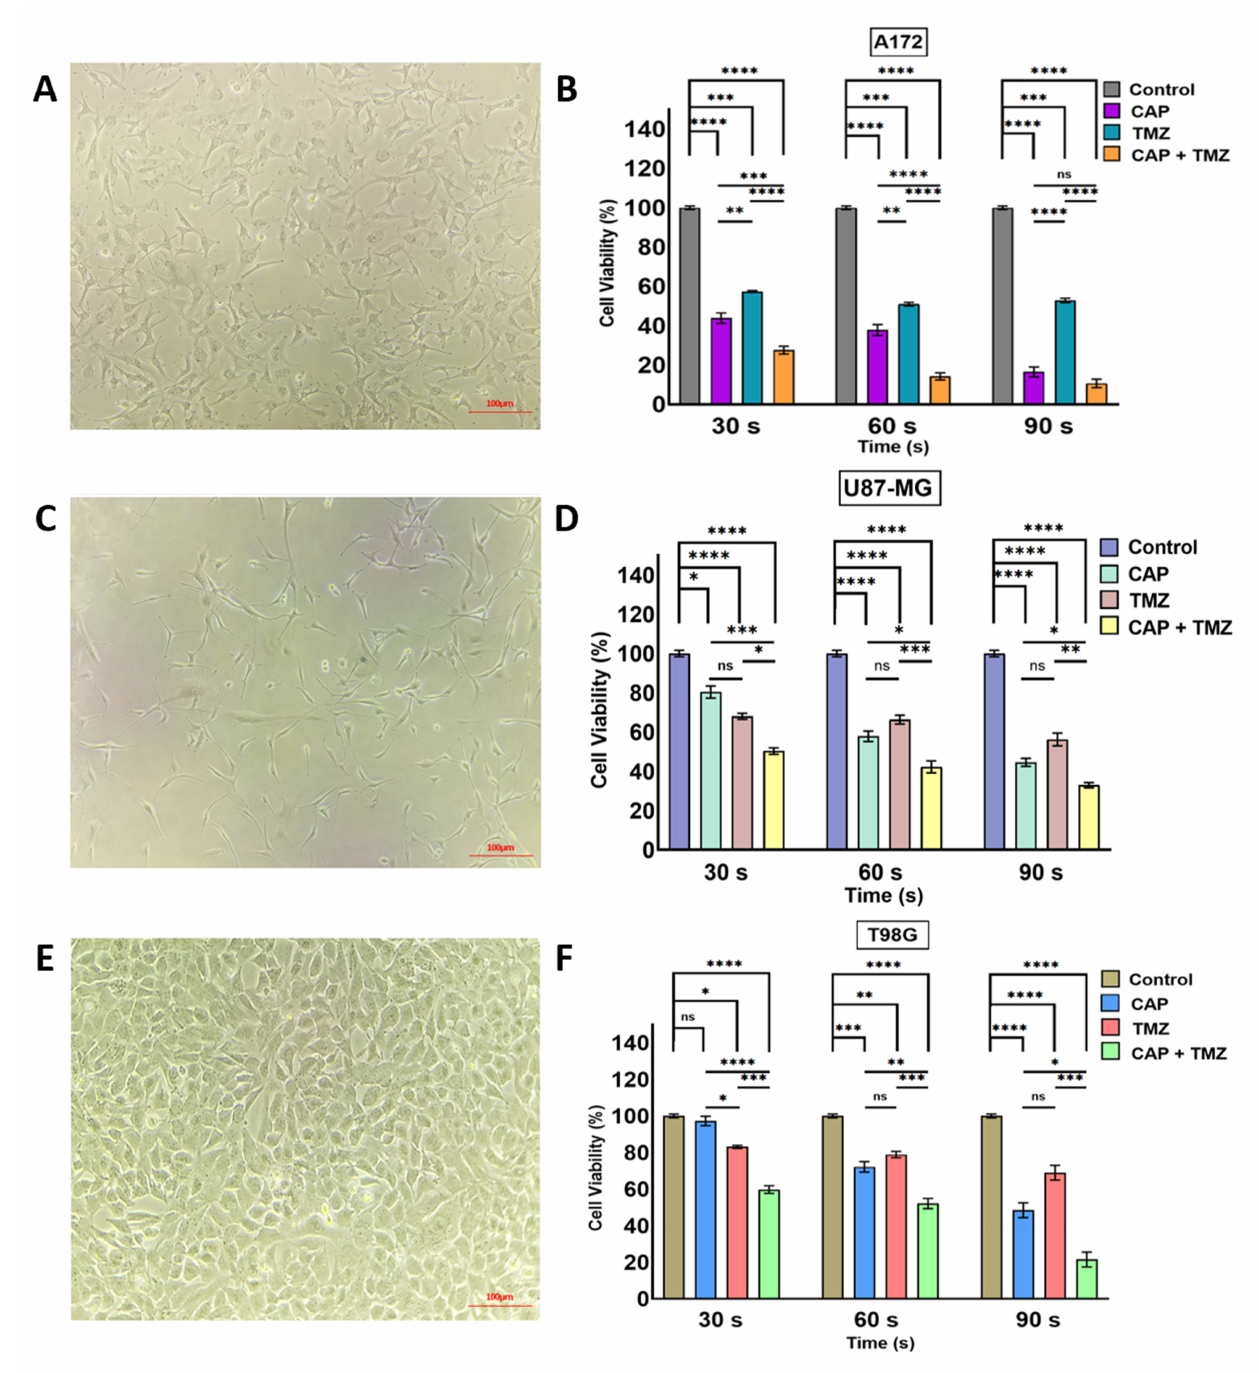
Figure 2. ( A ) Bright field image of A172 cells 40–50% confluent at 10 × magnification before seeding; ( B ) relative growth viability for A172 cells after 72 h; ( C ) bright field image of U87-MG cells 40–50% confluent at 10 × magnification; ( D ) relative cell viability for U87-MG cells after 72 h; ( E ) bright field image of T98G cells at 80–90% confluency; ( F ) relative cell viability of T98G cells after 72 h. All of the cell lines were treated with CAP, TMZ, and the co-treatment of CAP + TMZ for 30, 60 and 90 s. The ratios of the treatment groups were normalized for each cell line to their relative untreated controls (0 s). A two-way ANOVA was performed to identify the statistical significance compared to the control and was followed by Dunnett’s multiple comparisons post hoc test. * p < 0.05; ** p < 0.01; *** p < 0.001; and **** p < 0.0001, ns—not significant vs. untreated control. n =